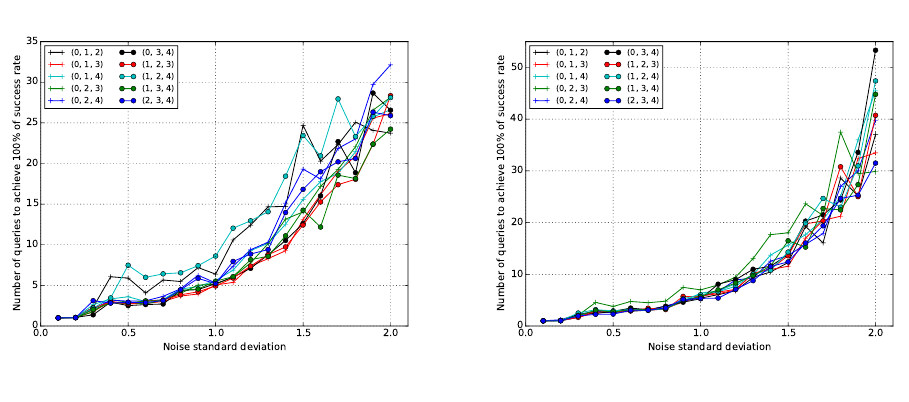
Figure 3: Evolution of the number of queries ( y -axis) to achieve a success rate of 100% according to an increasing noise standard deviation (in x -axis) for public points { 125 , 246 , 119 , 104 , 150 } ⊆ GF(2 8 ) (on the left-hand side) and { 86 , 23 , 115 , 107 , 189 } (on the right-hand